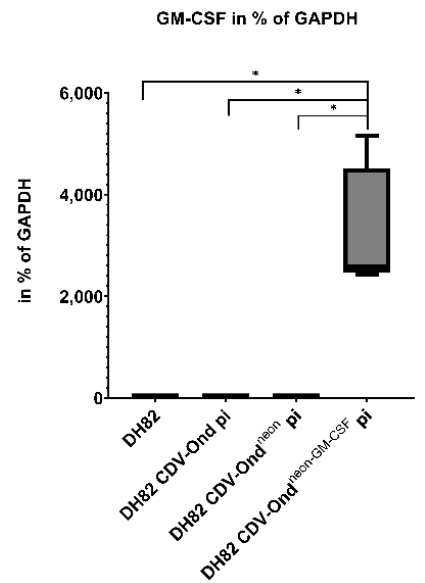
Figure 4. GM-CSF investigation on a transcriptional level in non-infected controls and DH82 cells persistently infected with CDV-Ond, CDV-Ond neon and CDV-Ond neon-GM-CSF . The number of GM-CSF mRNA transcripts was significantly higher in DH82 cells persistently infected with CDV-Ond neon-GM-CSF compared to all other cultures. Box plots represent minimum, first quartile, median, third quartile, and maximum. Significant differences (Mann–Whitney-U test) are labeled by asterisks, * = p ≤ 0.05. Table 3. Median and range of the number of GM-CSF mRNA transcripts in % of GAPDH.